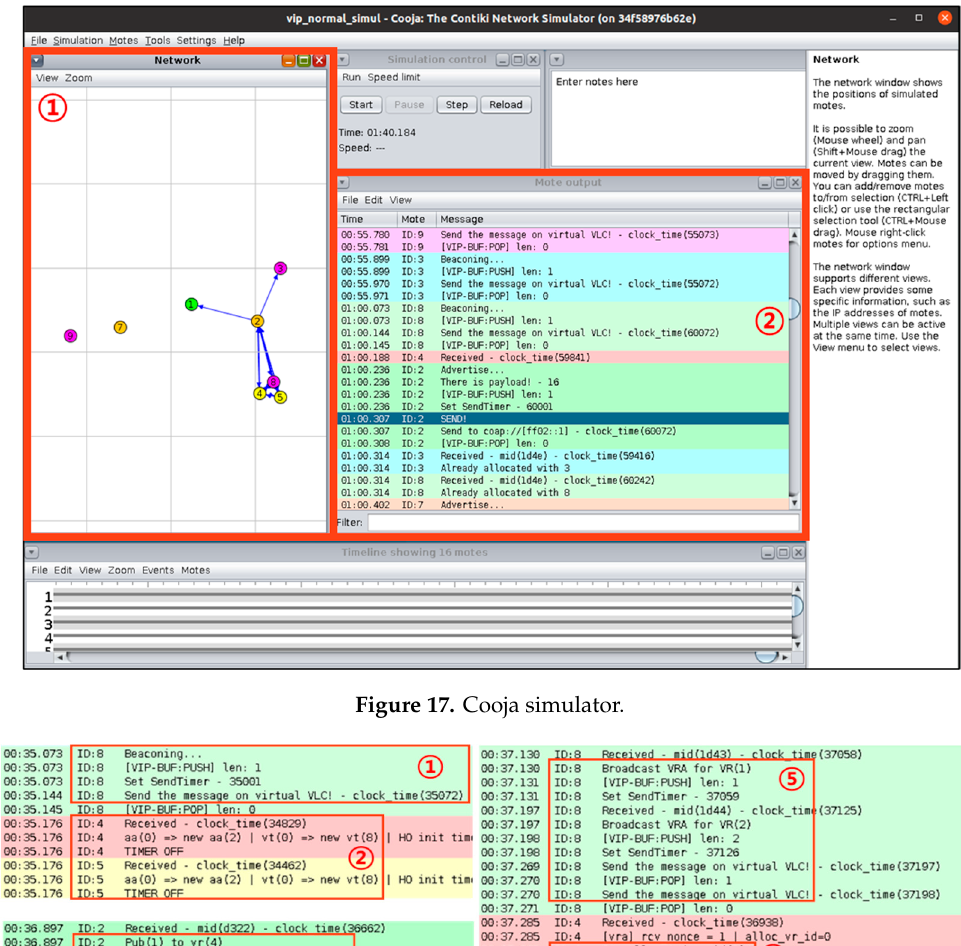
Figure 17. Cooja simulator. Electronics 2020 , 9 , x FOR PEER REVIEW